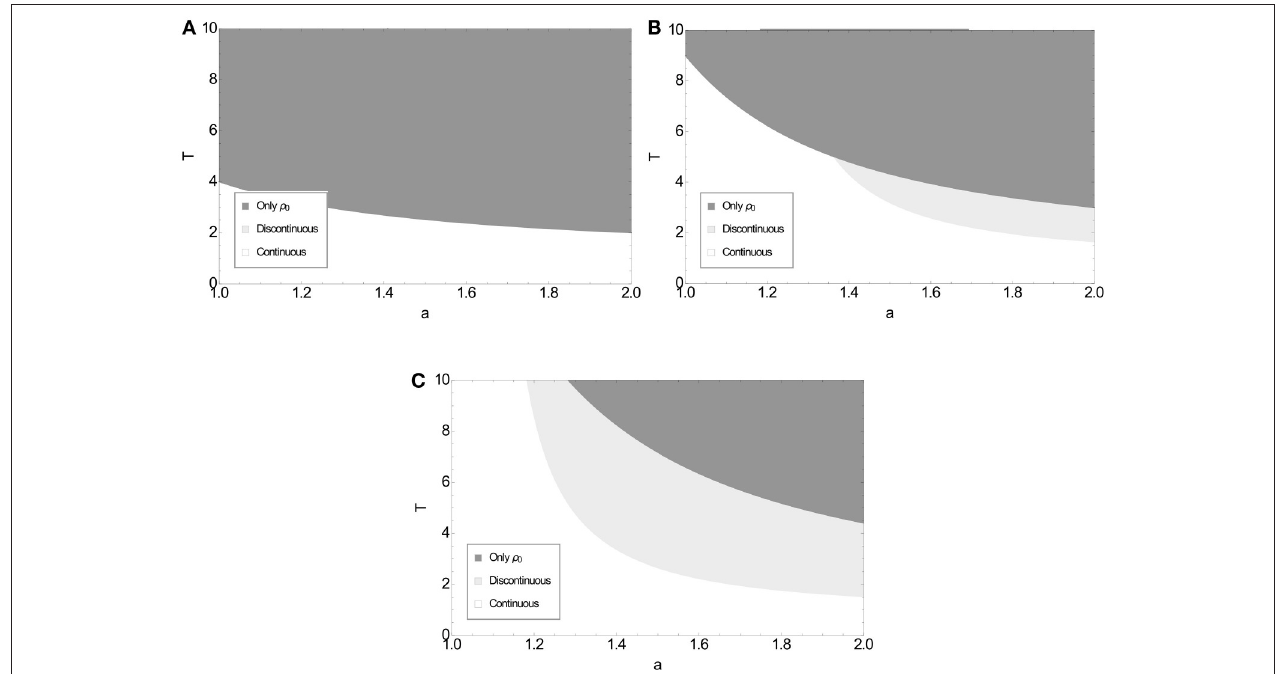
FIGURE 2 | Parameter space for a regular random network with k = 5,10,20 ( A–C , respectively). The white area is for continuous transitions while the light gray area is for discontinuous transitions. Both areas are separated by the curve given by Equation (10), corresponding to a supercritical pitchfork bifurcation diagram. In the dark gray area only the solution ρ * = 0 exists, i.e., there is not global